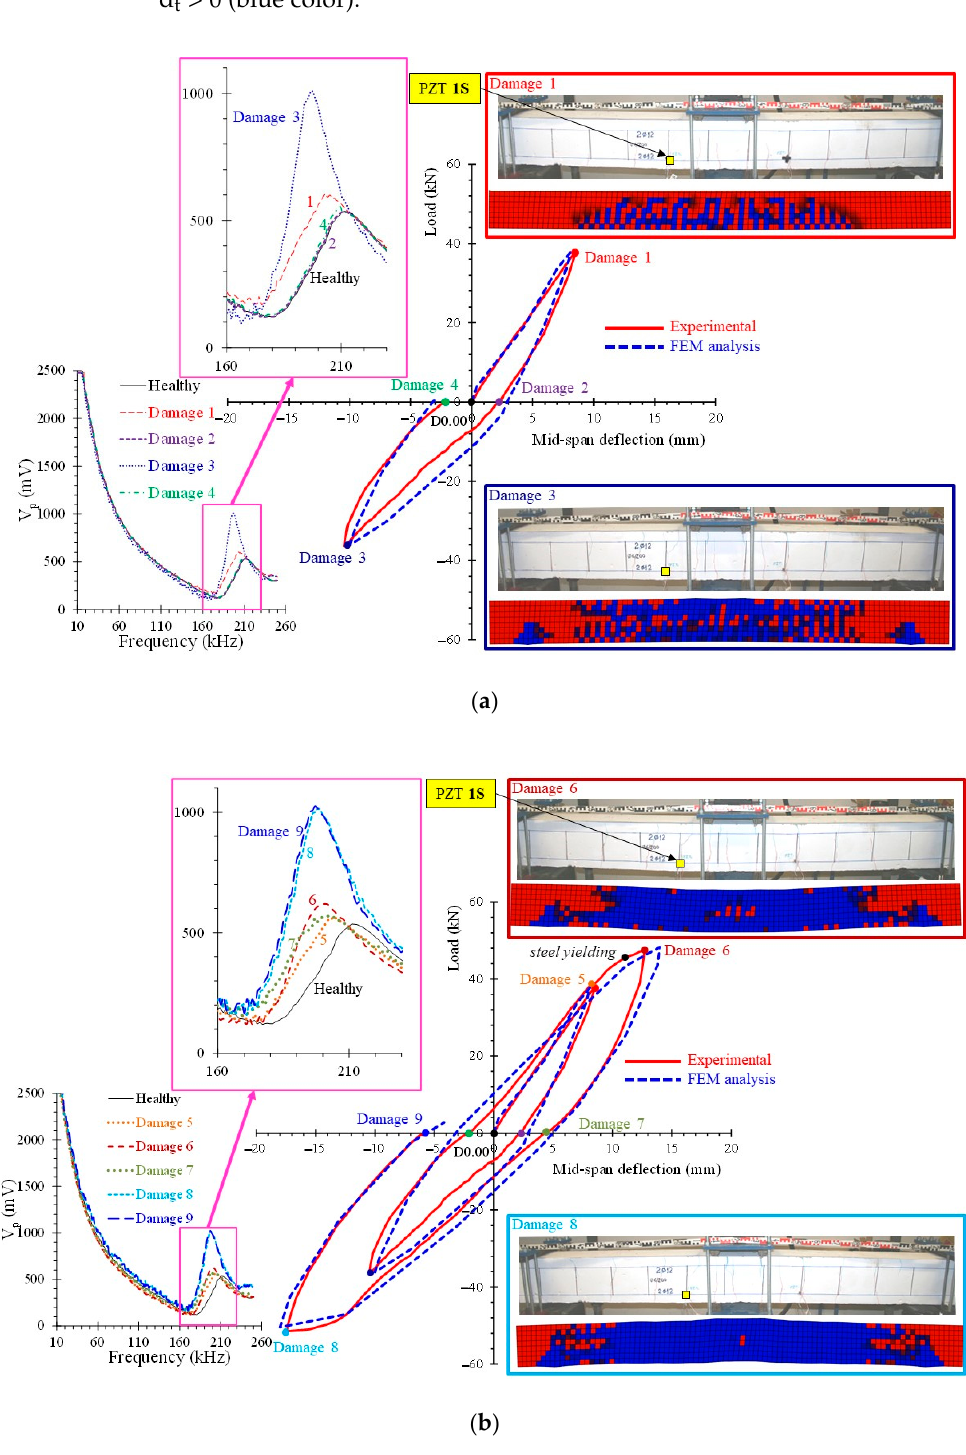
Figure 13. Comparisons between test and simulation results of the FLC beam under cyclic loading in load versus deflection curves and cracking patterns per various loading/damage levels for ( a ) the first loading cycle and voltage signal frequency response of the PZT 1S transducer; ( b ) both loading cycles and voltage signal frequency response of the PZT 1S transducer.